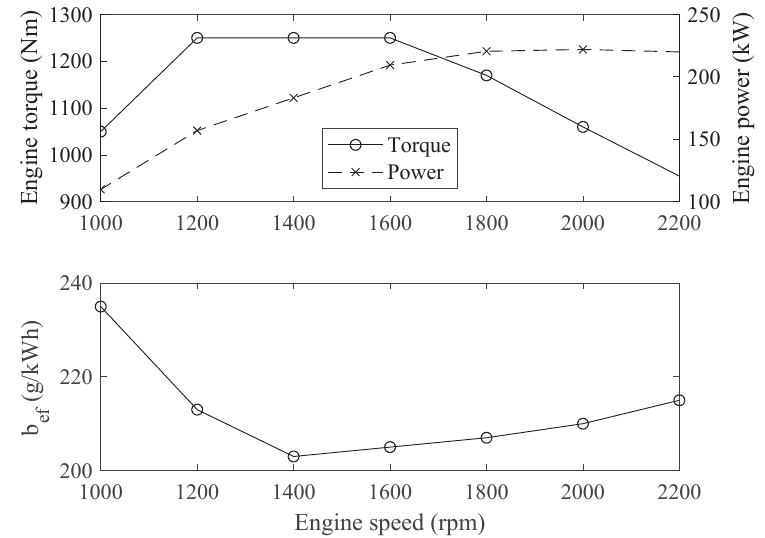
Figure 1. Example of a typical engine’s full-load power, torque, and specific fuel consumption curves according to engine manufacturer’s brochure [25].